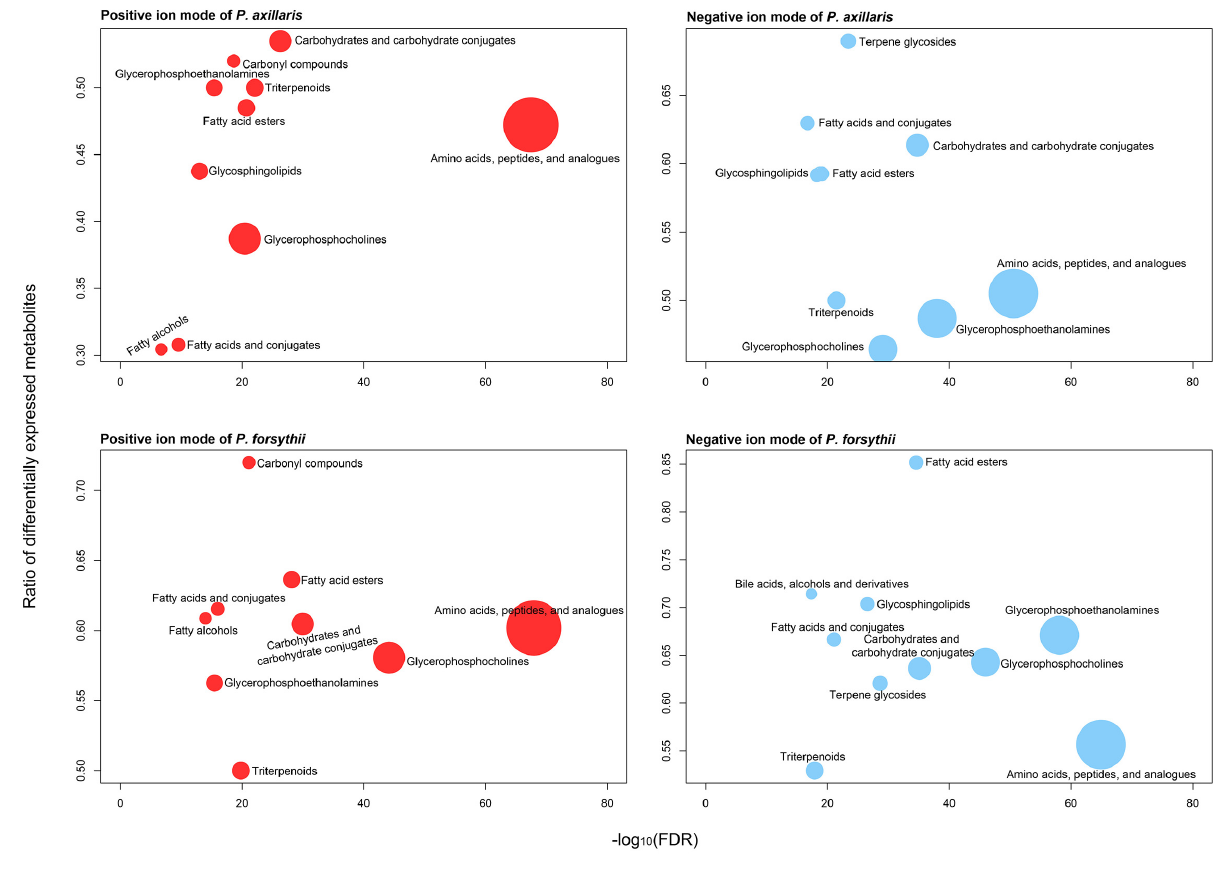
Frontiers in Ecology and Evolution |